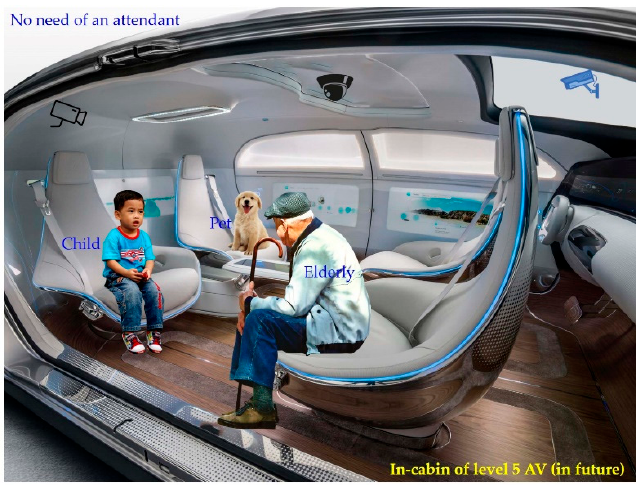
Figure 17. Example scenarios and use cases for an extension of the ODD of FAVs.